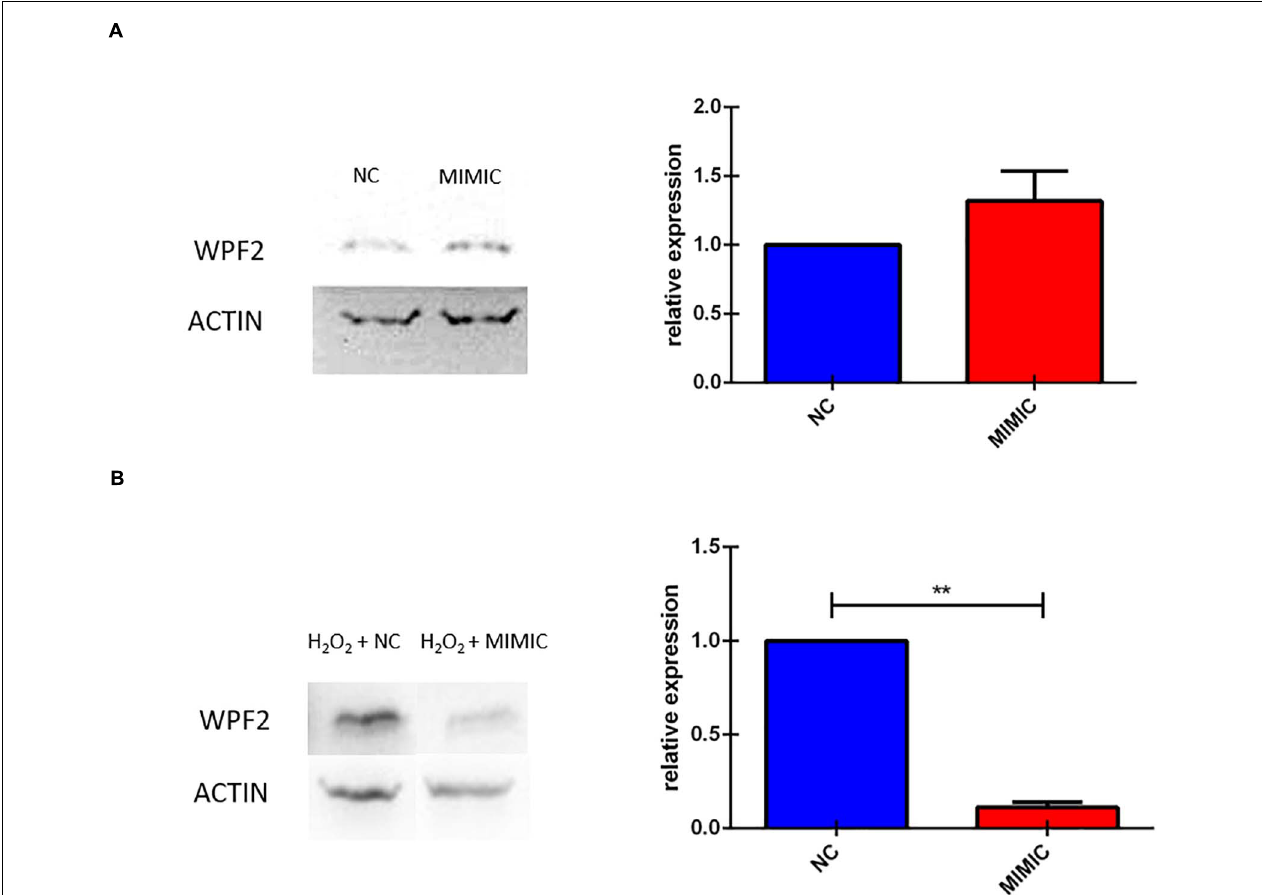
FIGURE 10 | miR-7b-3p overexpression in vitro reduces Wipf2 protein level upon oxidative stress condition. (A) After miR-7b-3p mimic transfection, the relative expression of Wipf2 protein was quantified both in primary cortical neurons in healthy state and (B) in N2a cells undergone oxidative stress condition. Data are shown as normalized relative expression values ( n = 3, ** p ≤